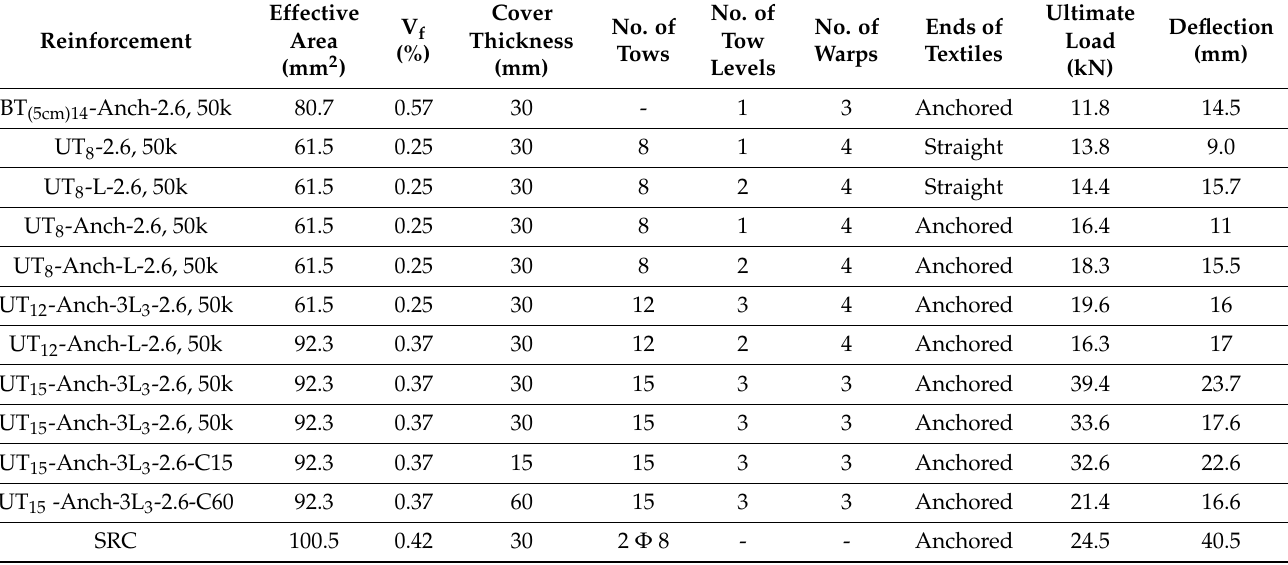
Table 3. Characteristics of tested beams.